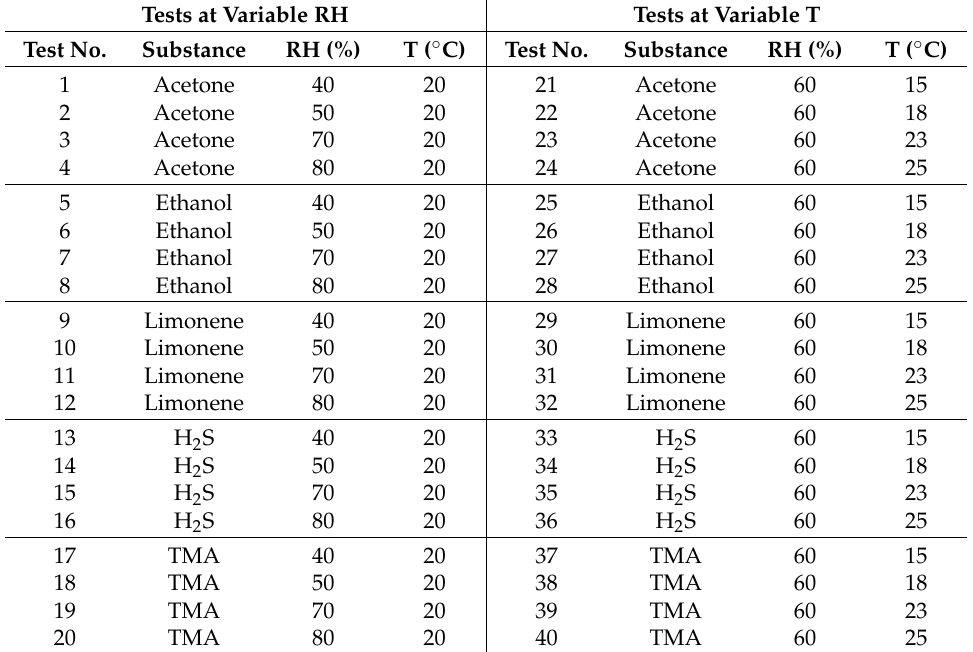
Table 4. Tests executed for the evaluation of the electronic nose responses invariability to variable T and RH.